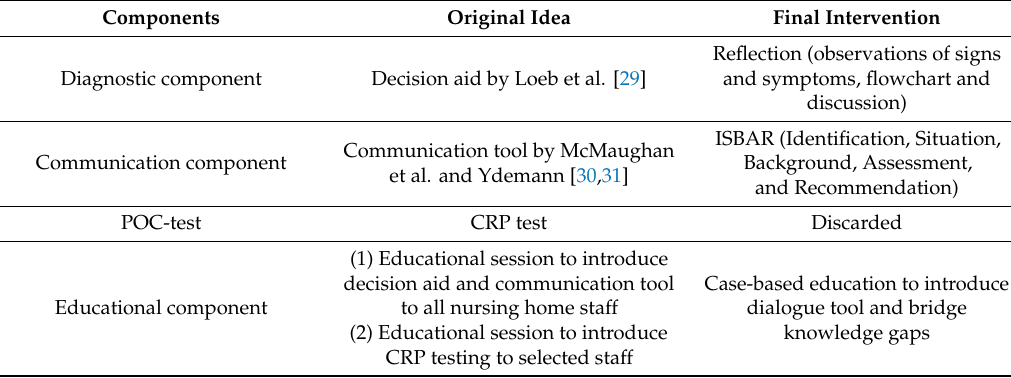
Table 1. Components of the original idea and the final